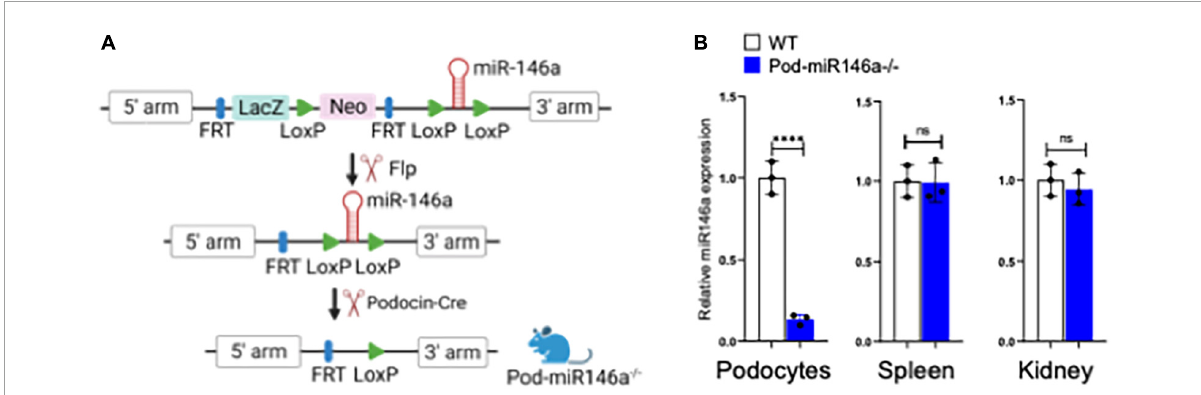
FIGURE1 Generation of podocyte-specific miR-146a deleted mice. (A) Schematic showing steps used in the generation of podocyte-specific miR146a knockout mice by crossing miR146a flox / flox mice with Flp-mice and subsequently with podocin-cre mice. (B) miR-146a expression levels measured by quantitative RT-qPCR from primary podocytes, spleen and whole kidney isolated from WT or Pod-miR146a mice. Statistics were performed using the Student’s t -test. Data shown are mean ± SEM ( n = 3). *** p < 0.0001; ns, no significant difference.